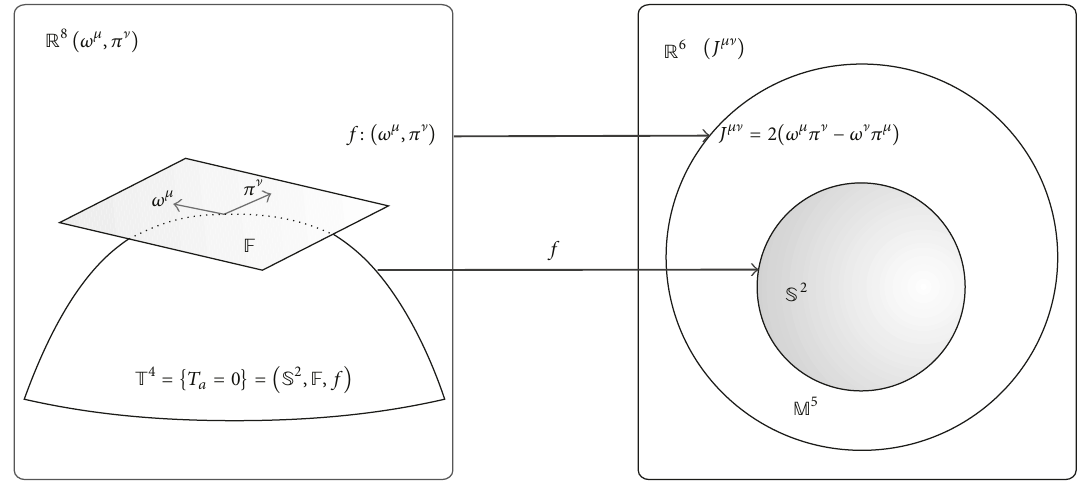
Figure 3: Fiber bundle T 4 associated with relativistic